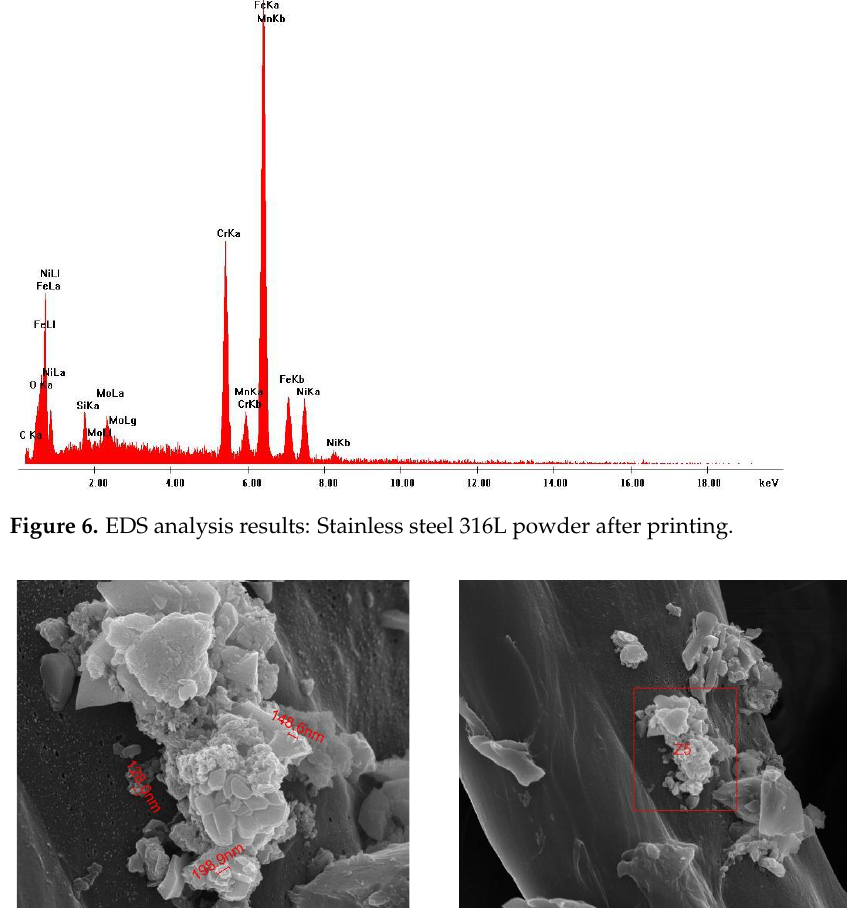
Figure 5. SEM analysis results: Stainless steel 316L powder after AM process. ( a ) Size and shape of particles in the sample; ( b ) image of the particle analyzed by EDS (results in Figure 6).